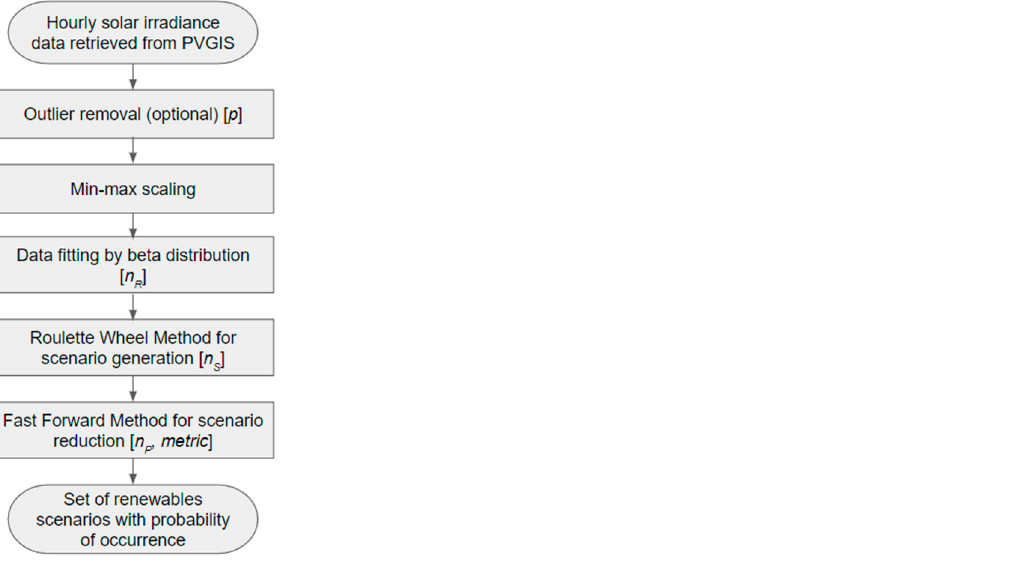
Figure 1. Overall description of the proposed tool. In square parentheses, the parameters that affect the considered step are reported.